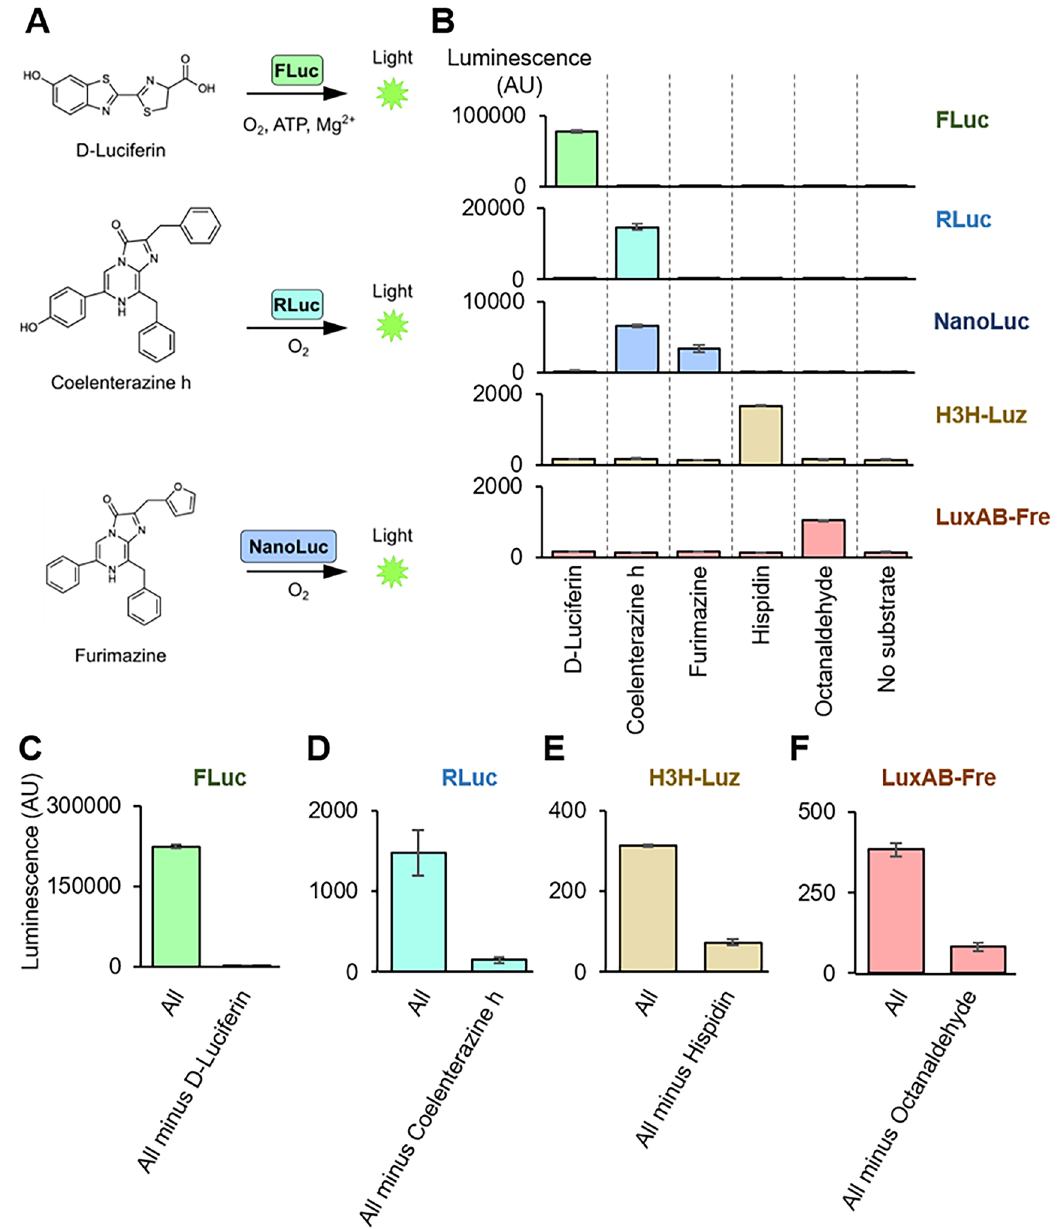
Figure 2. Characterization of substrate specificities. ( A ) Schematic image of firefly luciferase (FLuc), renilla luciferase (RLuc), and NanoLuc luciferase (NanoLuc) reactions. FLuc oxidizes D-luciferin with ATP and Mg + to produce light. RLuc and NanoLuc oxidize coelenterazine h and furimazine, respectively, with ATP to produce light. ( B ) Luminescence measurement for substrate specificity assay for 5 luciferases. The luciferases (FLuc, RLuc, NanoLuc, H3H-Luz, and LuxAB-Fre) were expressed in TXTL. Then, the individual substrates (D-luciferin, coelenterazine h, furimazine, hispidin, and octanaldehyde) with corresponding co-factors were added to the reaction and measured its light emission without emission filters. Substrate concentrations were 10 μM, except 1 mM for octanaldehyde. ( C – F ) The substrate multiplexing assay. The substrate mixtures were prepared as “All” (D-luciferin, Coelenterazine h, hispidin, octanaldehyde, Mg + , ATP, NADPH, FMN) or “All minus one” that contains all except one that a substrate is supposed to react with a tested luciferase. The assay was performed by mixing substrates with TXTL expressing ( C ) FLuc, ( D ) RLuc, ( E ) H3H-Luz, or ( F ) LuxAB- Fre, and the luminescence was measured without emission filters. ATP, adenosine triphosphate. The graphs show means with error bars that signify SEM (n =